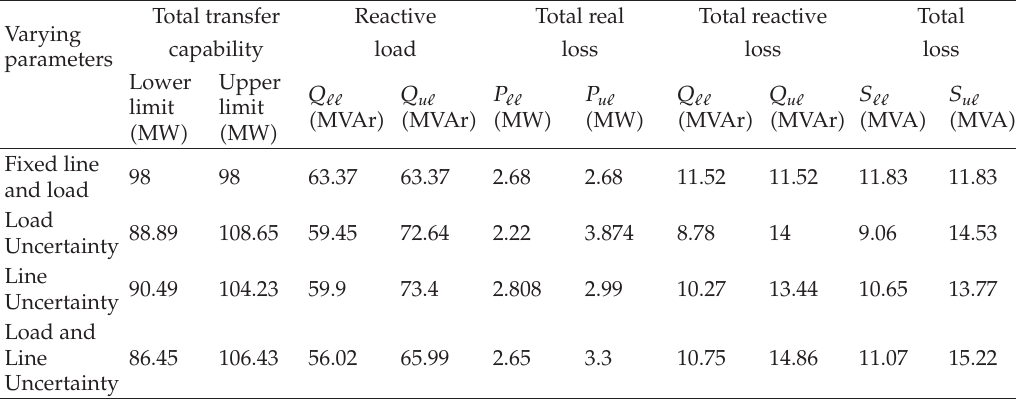
Table 5: Interval values for the operating parameters in case 1.